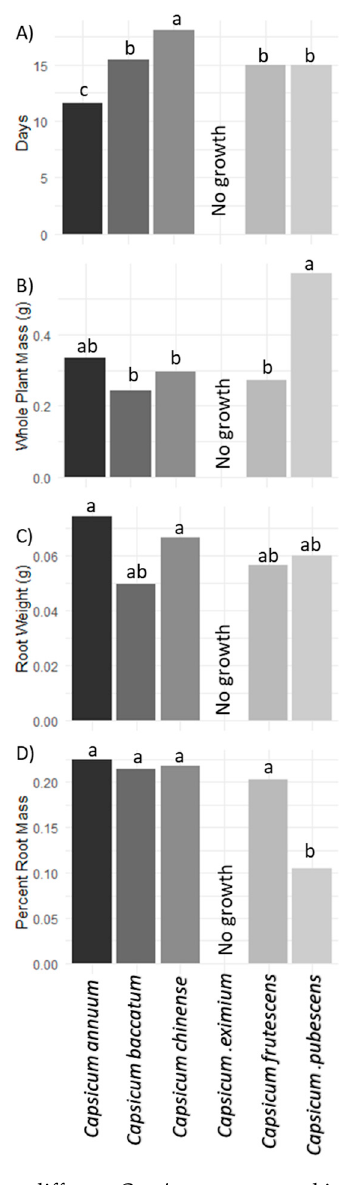
Figure 2. Vigor measurements from different Capsicum spp. tested in aeroponic conditions. ( A ) Time to node formation in days, ( B ) Total Dry Weight in grams (g), ( C ) Root Dry Weight in grams (g), ( D ) Ratio of Root Dry weight to Shoot Dry Weight. Letters indicate significant differences between means based on a Fischer’s protected LSD.